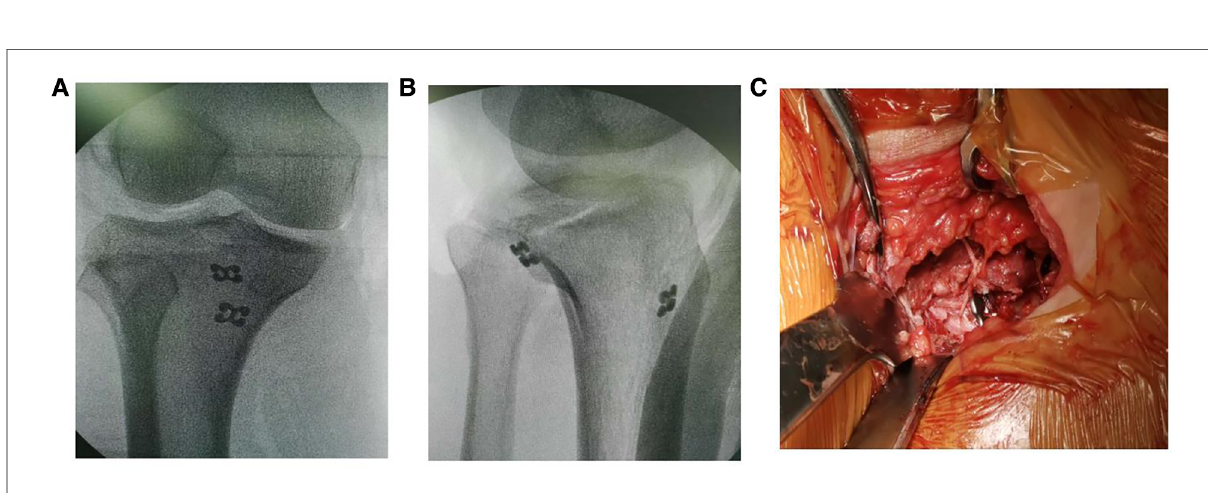
FIGURE 3 Intraoperative radiograph of double button plate fi xation ( A ) and ( B ) intraoperative x-ray showed that the fracture was well reduced and fi xed, ( C ) showed the titanium plate passed bone canal and position was